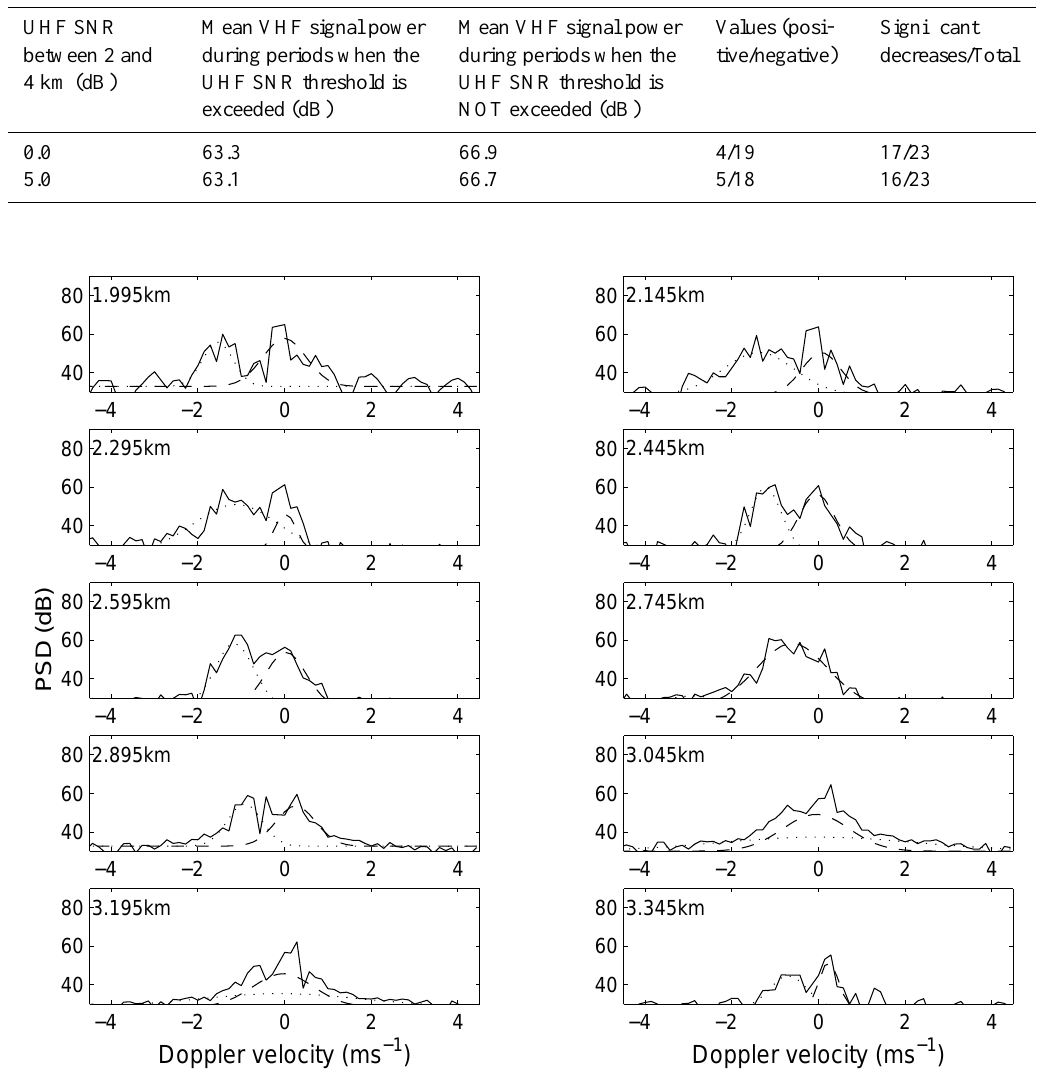
Fig. 2. VHF Doppler spectra taken at 07:24 UT on the 17 May 2001, the observation altitude being shown for each spectrum. The black line represents the raw data, and the dotted and dashed lines show fits to any possible Rayleigh or clear air echoes using a technique similar to that described in Rajopadhyaya et al.